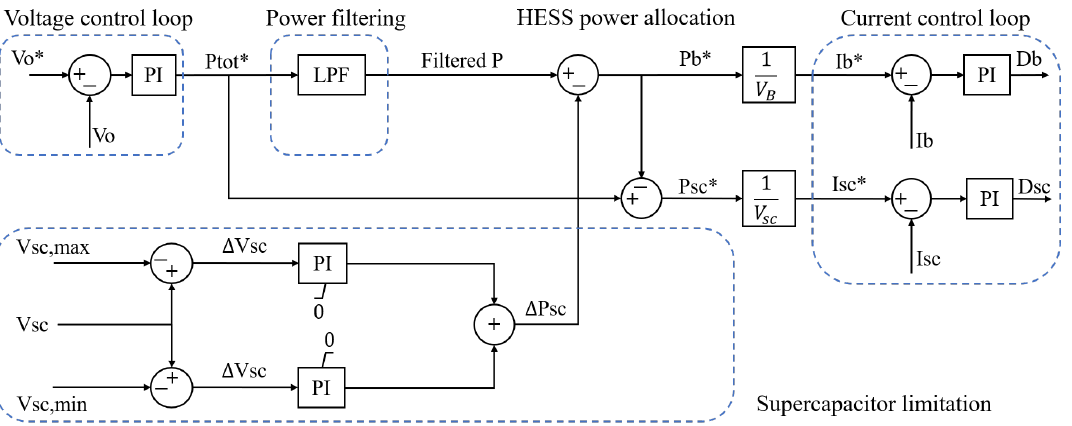
Figure 2. Proposed HESS control